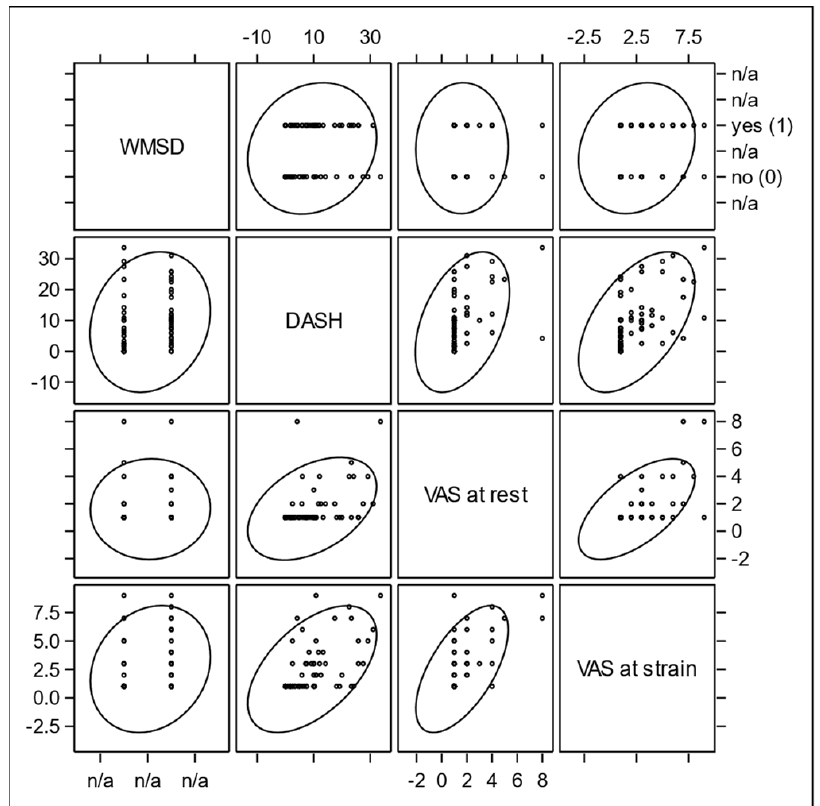
Figure 1. Scatter plot matrix showing the bivariate distributions for all pair-wise combinations of WMSDs, DASH, VAS at rest, and VAS at strain.